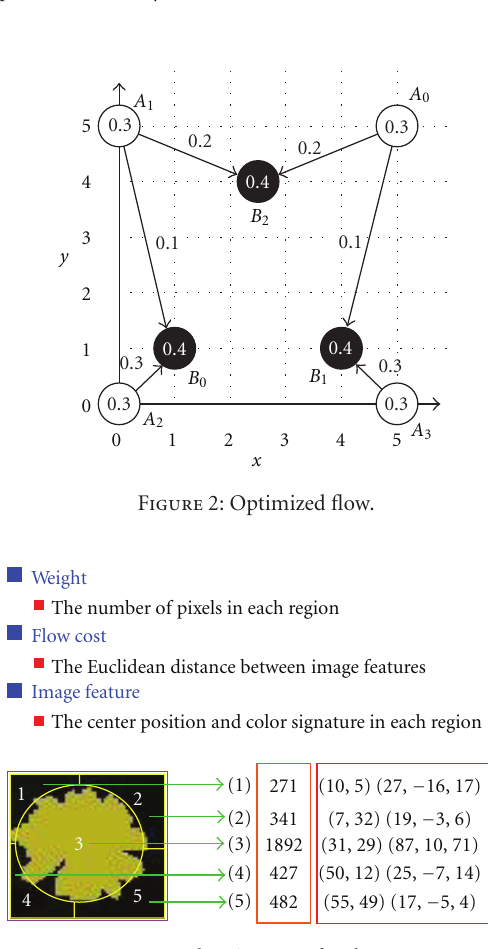
(b) Perceptual dissimilarity. Figure 1: An illustration of perceptual dissimilarity.